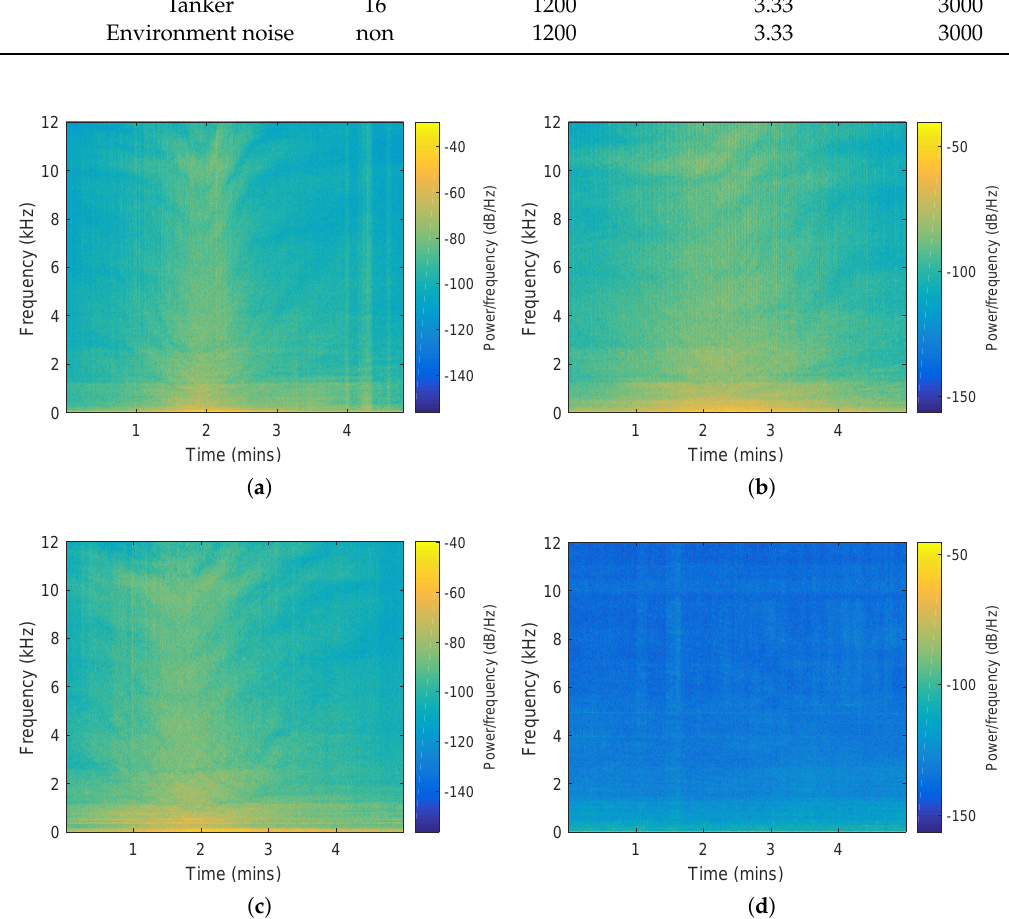
Figure 2. Spectrogram of